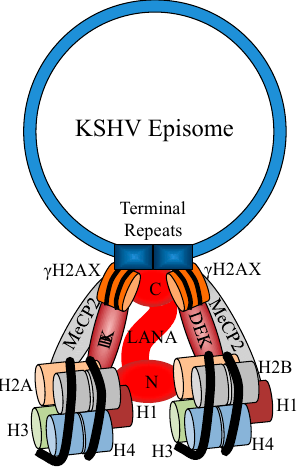
Figure 1. Schematic representation of latency-associated nuclear antigen (LANA)-mediated Kaposi sarcoma-associated herpes virus (KSHV) episomal persistence after infection. LANA binds to LANA binding sequences in the episome terminal repeats by its C terminal region. In this model, γ H2AX participates in KHSV episomal persistence possibly by strengthening the interaction between C-LANA and terminal repeat (TR) as proposed by Jha et al. , 2013